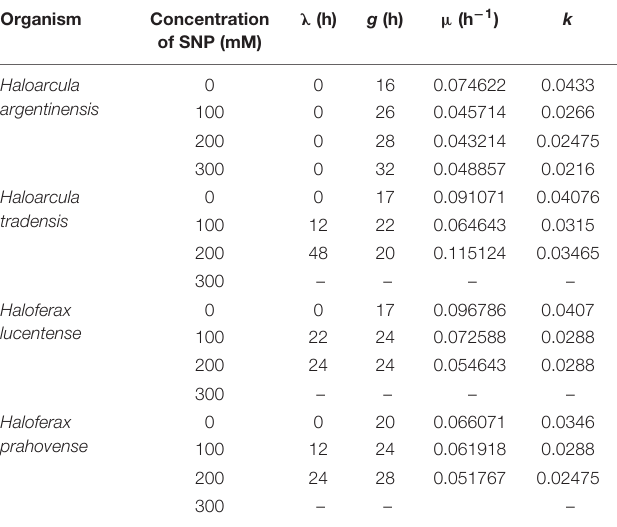
TABLE 3 | Growth kinetics of the haloarchaea in the presence of varying concentrations of SNPs. Organism Concentration of SNP